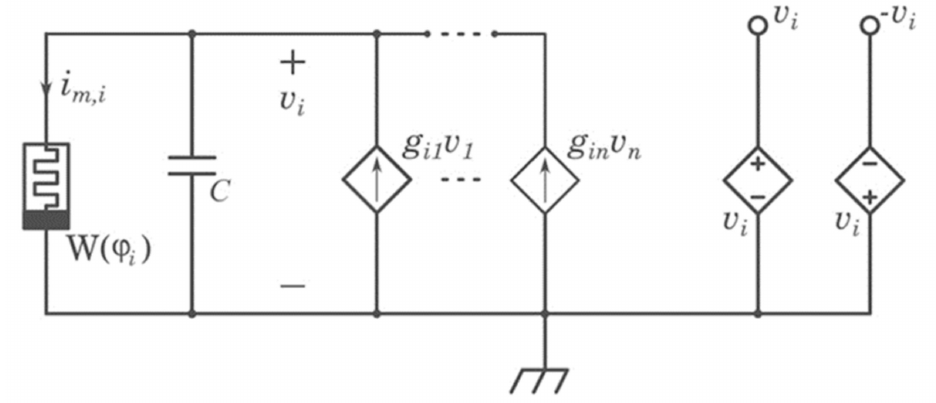
Figure 2. Implementation of MCNN